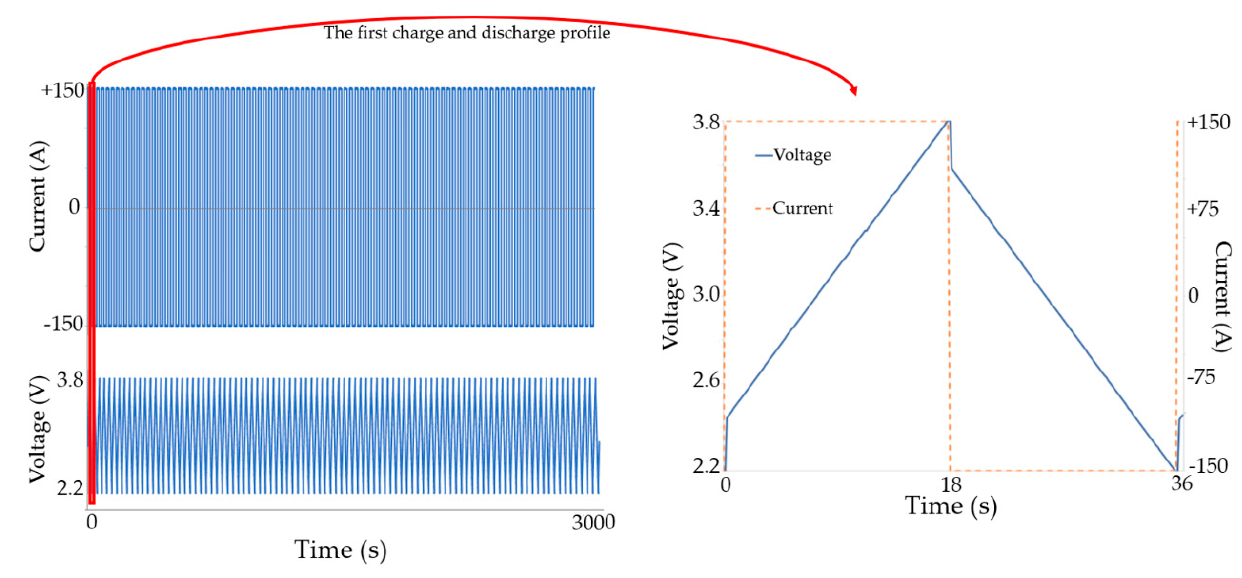
Table 2. The generated heat of the LiC cell, in regard to its dimensions for the continuous 150 A current profile.